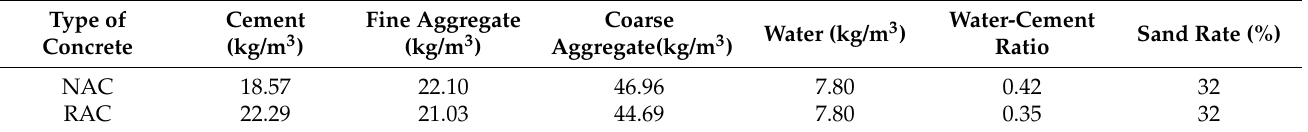
Table 3. Matrix proportions of different